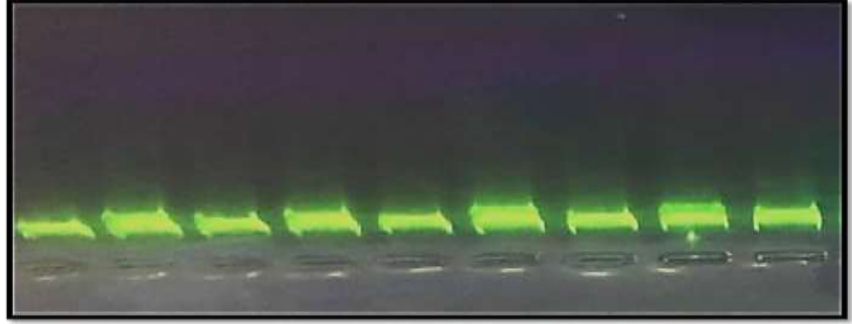
Figure 1: Gel-electrophoresis of DNA extracted from the whole blood sample.